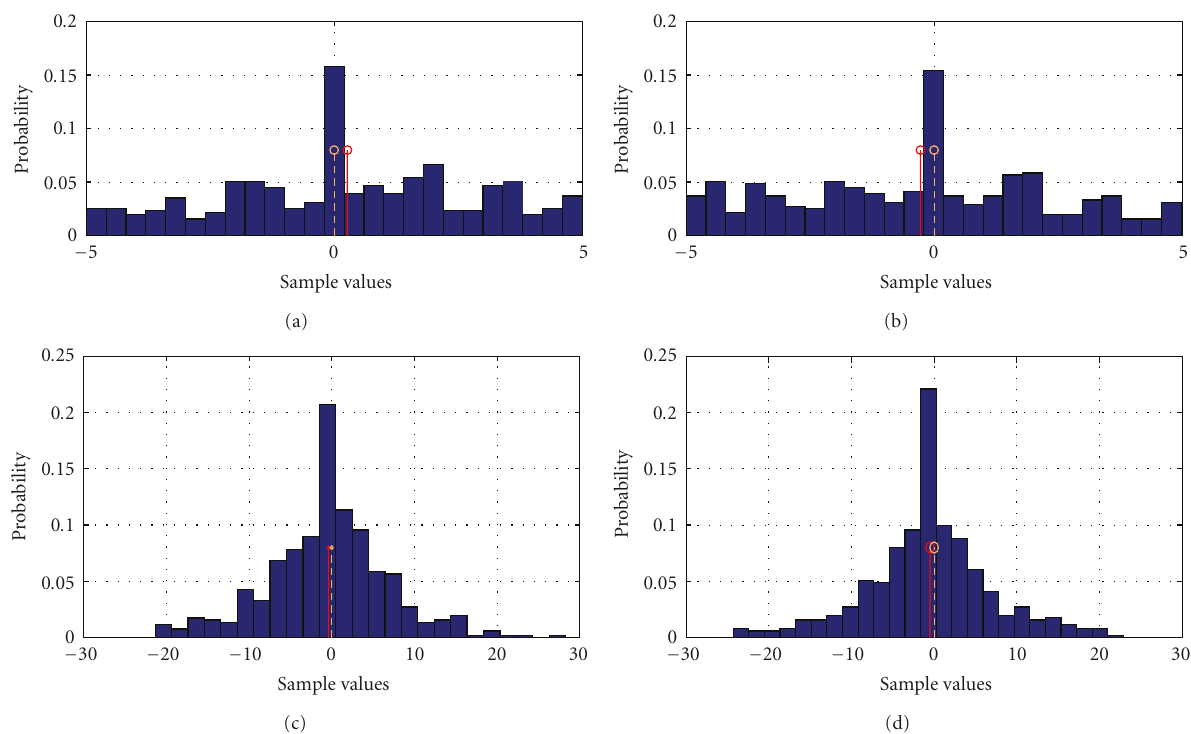
Figure 8: Histograms of R ( p , n ) (left column) and I ( p , n ) (right column) for noise-free ((a) and (b)) and noisy ((c) and (d)) FM signal s 2 ( n ) for f p = 32 Hz, PCK RE = 0 . 250, MAD RE = 1 . 838, PCK IM = 0 . 261, MAD IM = 1 . 84 (noise-free case), PCK RE = 0 . 219, MAD RE = 3 . 75, PCK IM = 0 . 211, and MAD IM = 3 . 74 (noisy case).